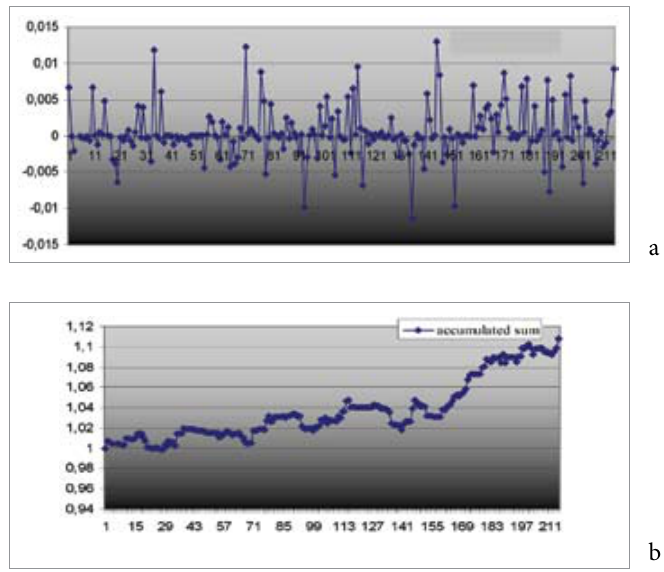
Fig. 5. Results of one of the strategies